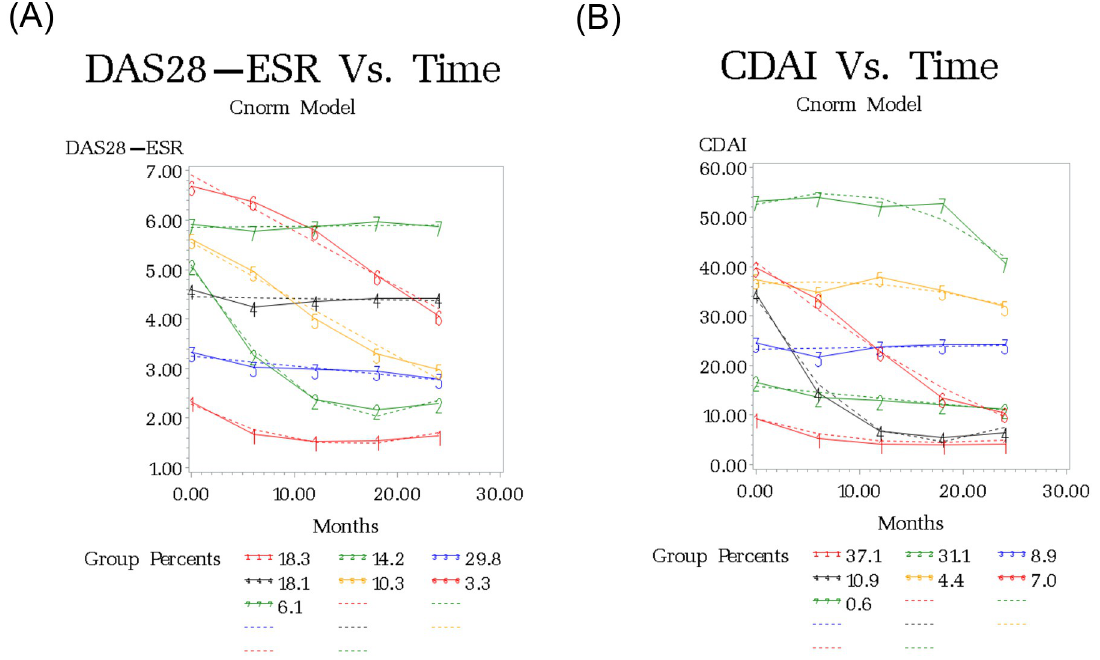
Fig 3. Observed and fitted trajectories from latent growth curve analysis for disease course over 2 years in patients with established RA. A. DAS28-ESR. DAS28-ESR category : Remission: DAS-ESR < = 2.6; LDA: DAS-ESR < = 3.2; Moderate: 3.2 < DAS28-ESR < = 5.0; Severe: DAS28-ESR > 5.0. B. CDAI. CDAI category : Remission: CDAI < = 2.8; LDA: CDA < = 10; Moderate: 10 < CDAI < = 22; Severe: CDAI > 22. Dashed line: fitted values. Solid line: observed